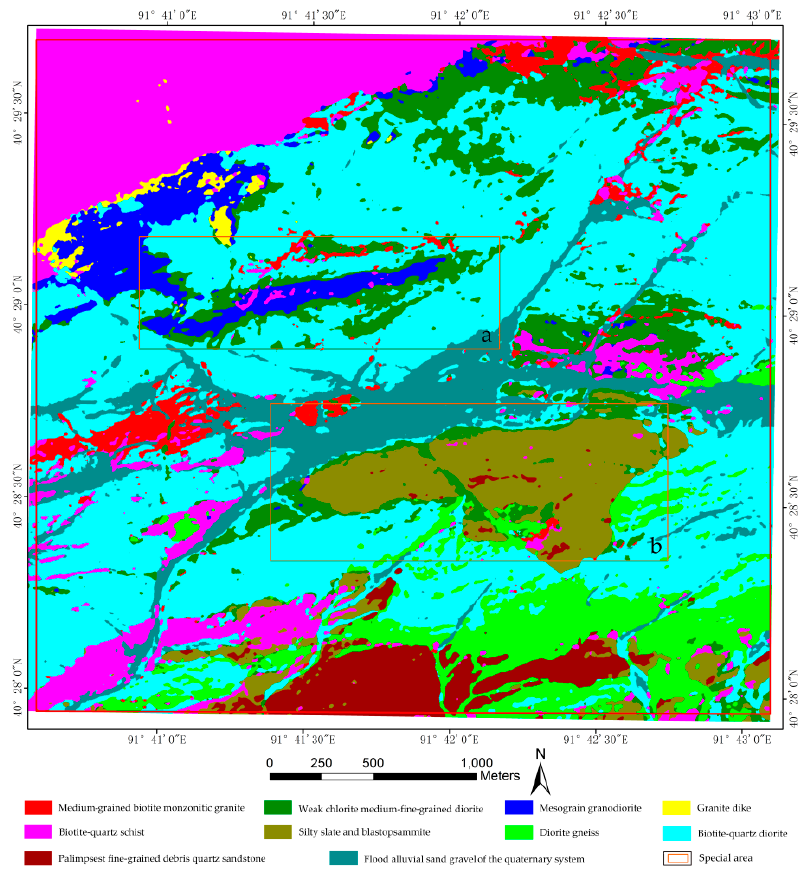
Figure 5. Lithological classification map of WV-3 data after the post-classification processing. ( a ) Mesograin granodiorite was surrounded by weak chlorite medium-fine-grained diorite, and it was connected with biotite–quartz diorite; and ( b ) weak chloritization and diorite gneiss distributed around a